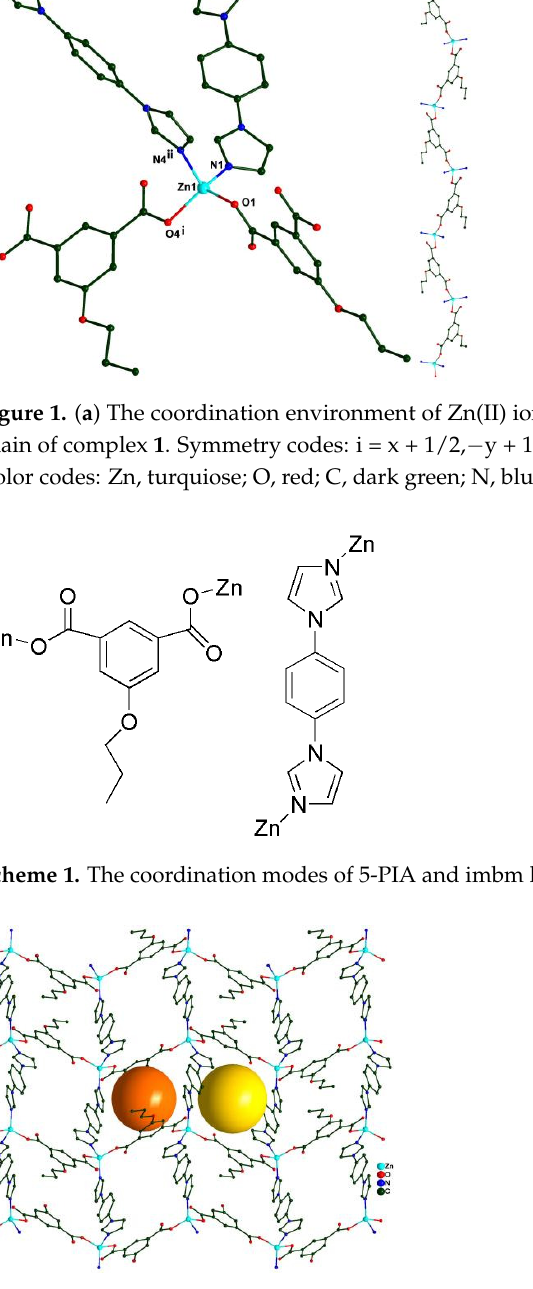
Scheme 1. The coordination modes of 5-PIA and imbm ligands in complex 1